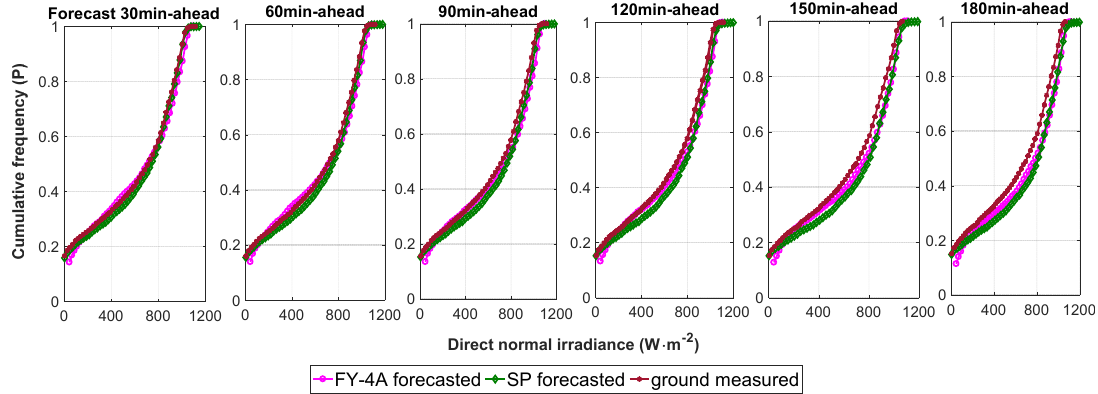
Figure 11. The DNI cumulative frequency curves for time horizons from 30 to 180 min.